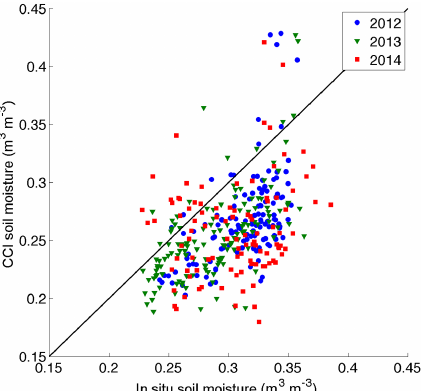
Figure 12. Scatter plot of daily averaged top soil layer ESA CCI soil moisture data product estimate comparison against daily spatially weighted areal average in situ observations for the years 2012, 2013, and 2014.